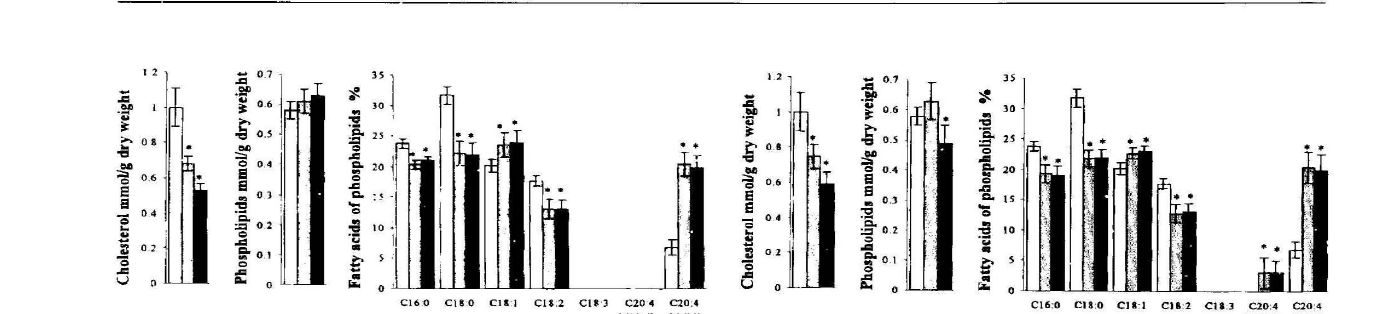
Figure 4. Concentration (mean±S.D.) of cholesterol and phospholipids, as well as fatty acid content (in percent: mean ± S.D.) of phospholipids in controls (open bars) and in samples with 2.4 nmoljg wet weight (dotted bars) or with 4 nmol/g wet weight (hatched bars) quinolinilic acid. Samples of rat liver tissue homogenates were used to test for phospholipid biosynthesis in vitro. Incubation medium: Krebs -Ringer- phosphate buffer, containing 0.3% albumin (pH=7.4), fatty acid mixture and glycerol. Samples were in cubated twice for 4 h at 37"C. *The changes are statistically significant (p<O.OO 1). acid (p<O.OOl), while an enchanced incorporation of 8, 11, 14, 17 arachidonic acid into phospho lipids was found in samples containing both con centrations (2.2 and 4 nmoljg wet weight) of 3- hydroxyanthranilic acid. The cholesterol and phos pholipid content was not altered in samples con taining 2.2 nmoljg wet weight 3-hydroxyanthran ilic acid, while addition of 4 nmolj g wet weight 3- hydroxyanthranilic acid induced a decrease of cho lesterol and phospholipid content (p<O.OOl; p< 0.05 ) in